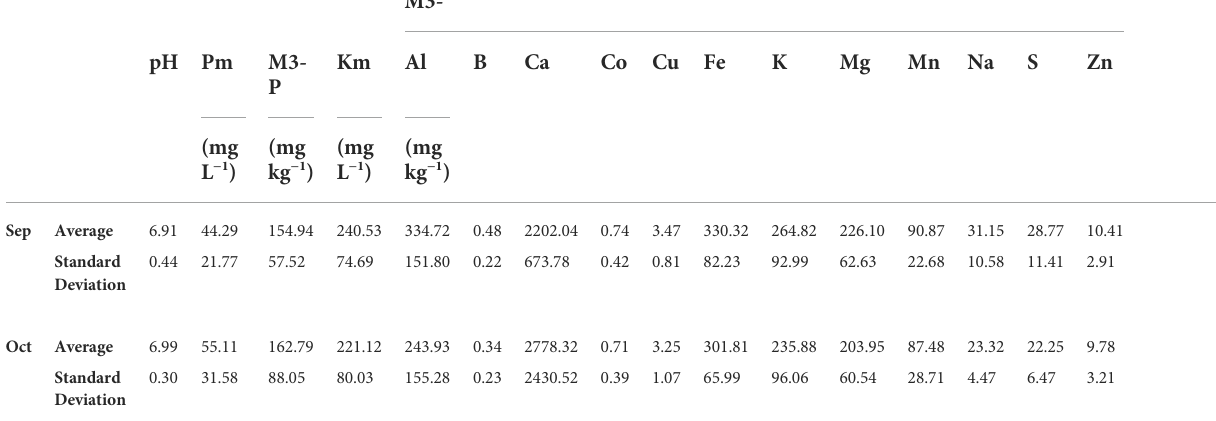
TABLE 3 Whole farm average concentrations for all roadway sampling locations across the two sampling